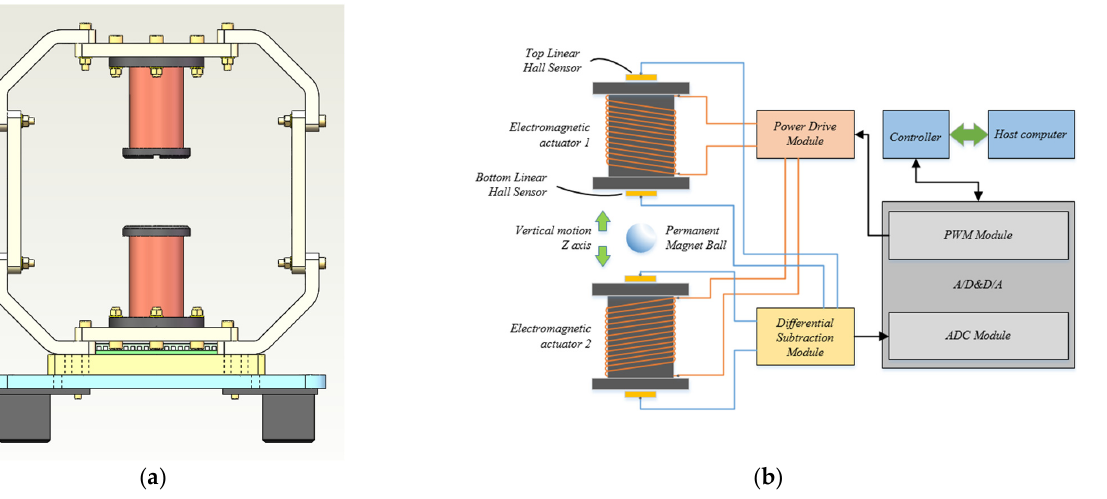
Figure 1. Mechanical structure and system control model of magnetic levitation system. ( a ) External magnetic field actuation device; ( b ) System control model.